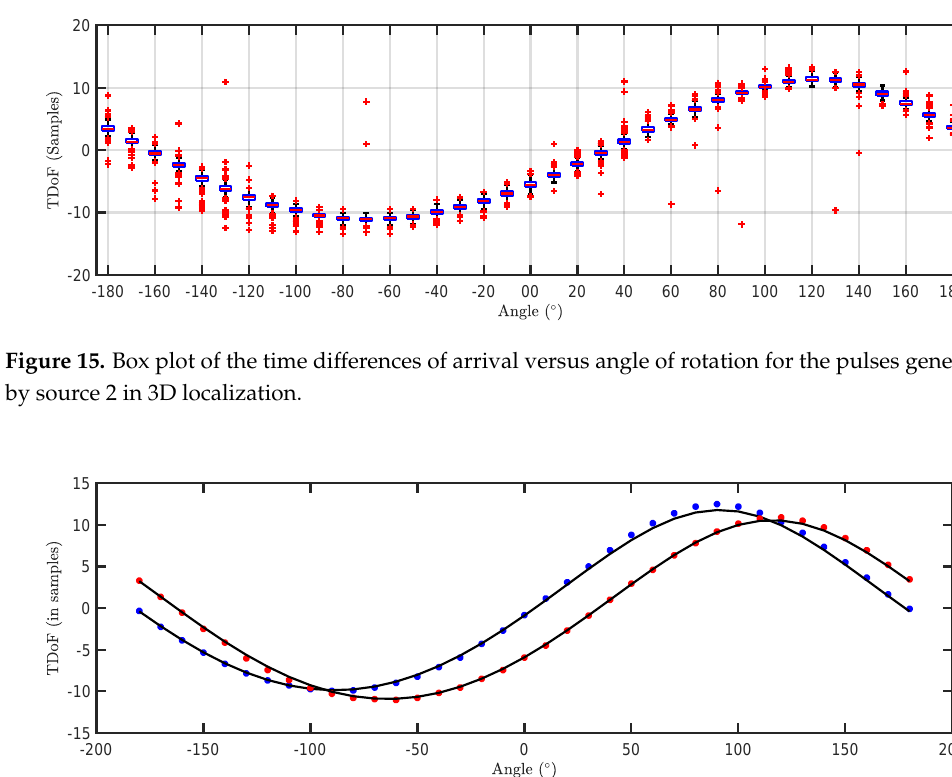
Figure 16. Median of all TDOA versus rotation angle in 3D localization with the fitting function. Blue plot corresponds to the fitting function for source 1 and red plot to source